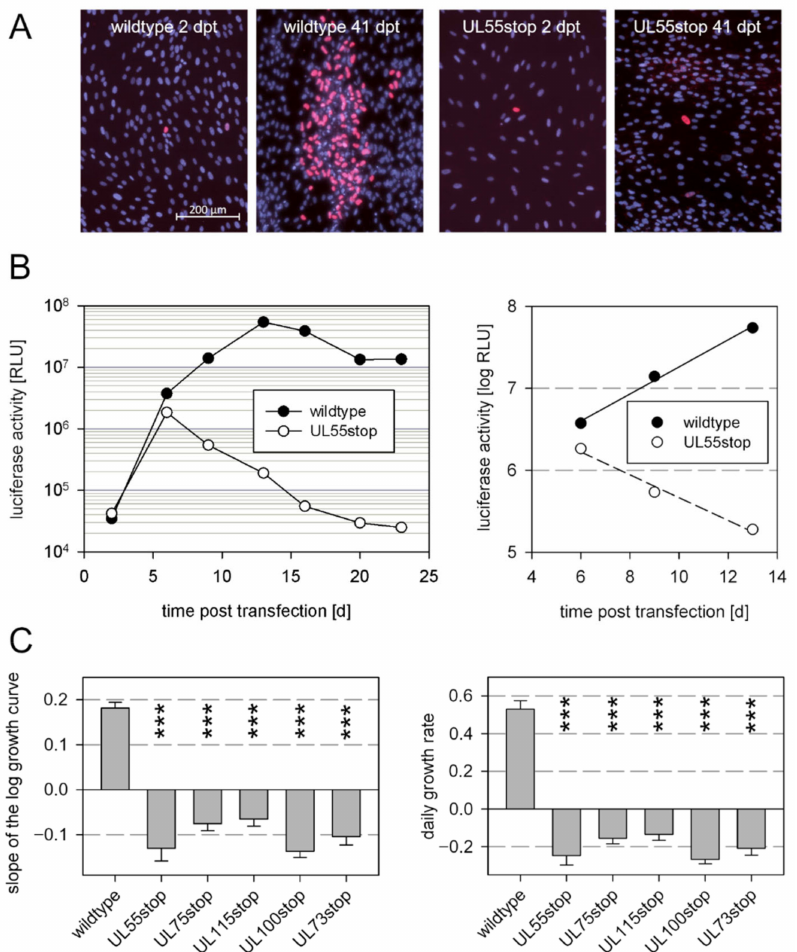
Figure 1. Effect of stop mutations in viral genes encoding for envelope glycoproteins on growth of the cell-associated model virus Merlin pAL1502-GLuc. ( A ) Detection of viral immediate early antigen 2 d post-transfection (dpt) as a proof of successful transfection and 41 dpt as a readout of viral growth. Data for the UL55stop mutant are shown as an example. ( B ) Measurement of Gaussia luciferase activity (relative light units; RLU) as a reporter for viral gene expression. The period during which growth dynamics were exponential and appear linear on a logarithmic scale were used for linear regression analyses to determine the slope as a readout for viral growth. Data for the UL55stop mutant are shown as an example. ( C ) Growth dynamics of Merlin pAL1502-GLuc (wildtype virus) and glycoprotein-stop-mutants thereof. The daily growth rates (right panel) were calculated from the slopes (left panel) as 10 slope − 1. Bars indicate mean values of eight replicates (two measurements of two independent transfections of two clones per gene). Error bars represent the standard error of the mean (SEM). Asterisks indicate significant differences as compared with wildtype (***, p <